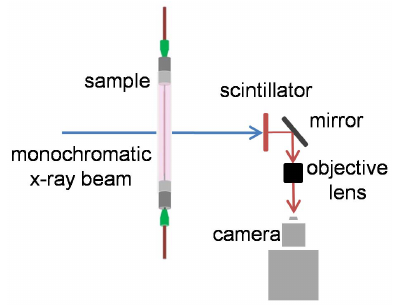
Figure 2. Schematic of x-ray PIV in collagen vessel